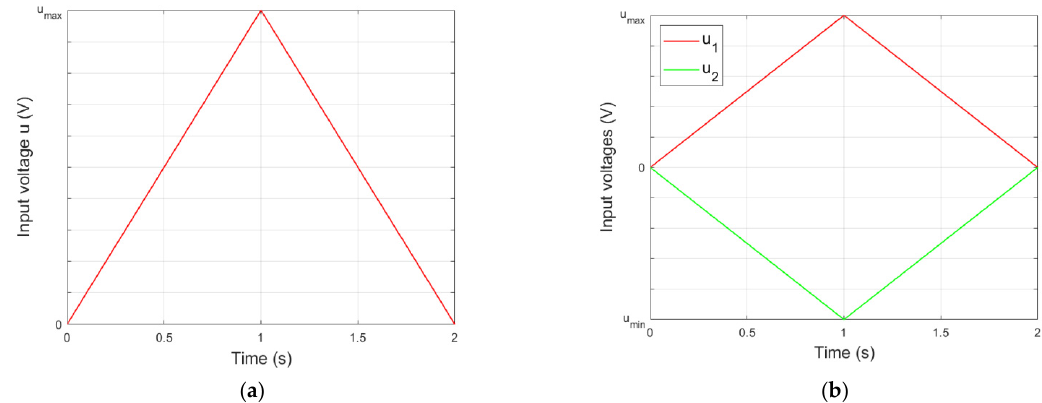
Figure 3. Courses of input voltages ( a ) in experiments 1–10 and ( b ) in experiments 11–20. Table 2. Maximum and minimum values of input voltages in laboratory experiments 1 to 20.